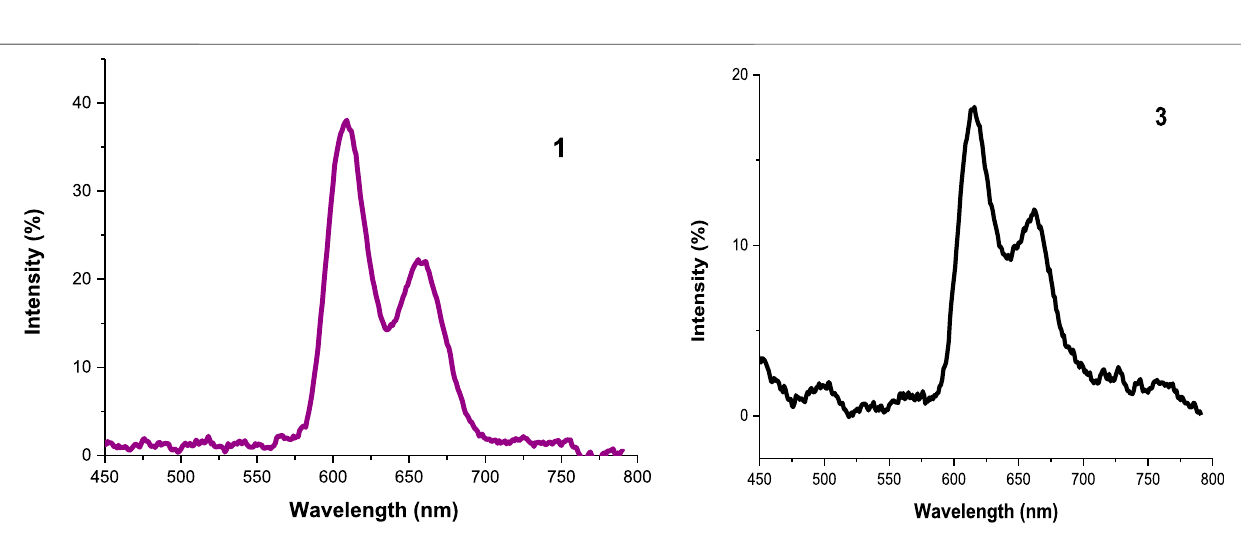
FIGURE 6 | The emission spectra of 1 and 3 in